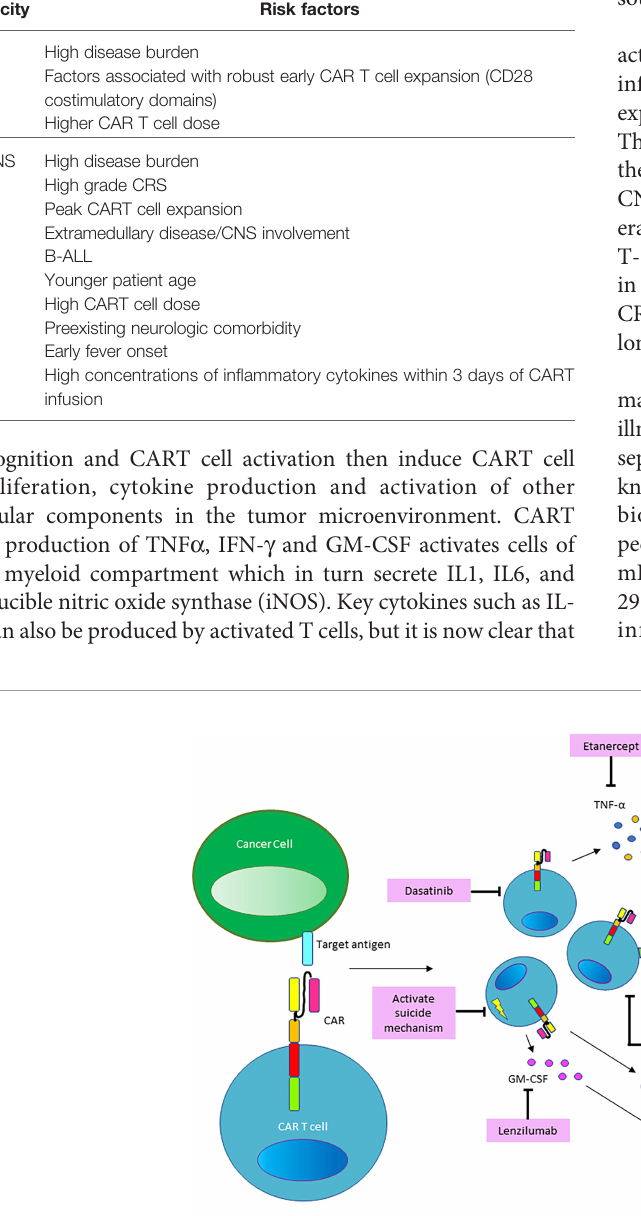
TABLE 2 | Risk factors associated with toxicity.